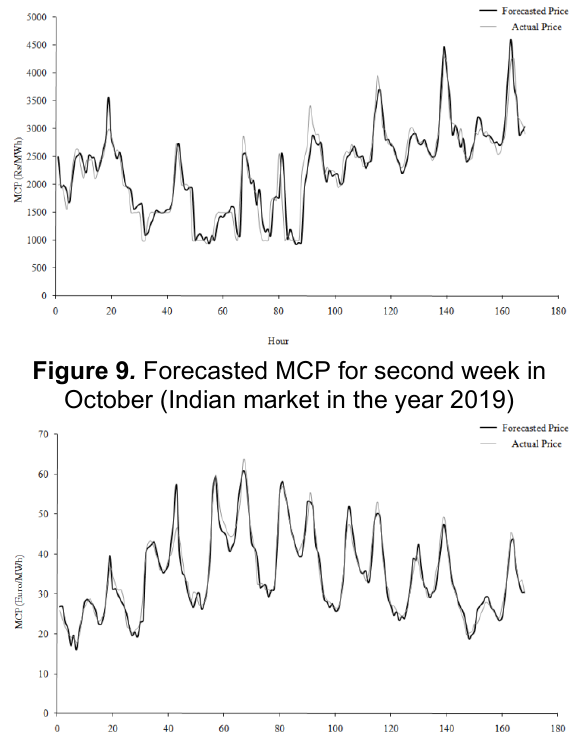
Figure 10 . Forecasted MCP for a winter week (Austrian market in the year 2015)